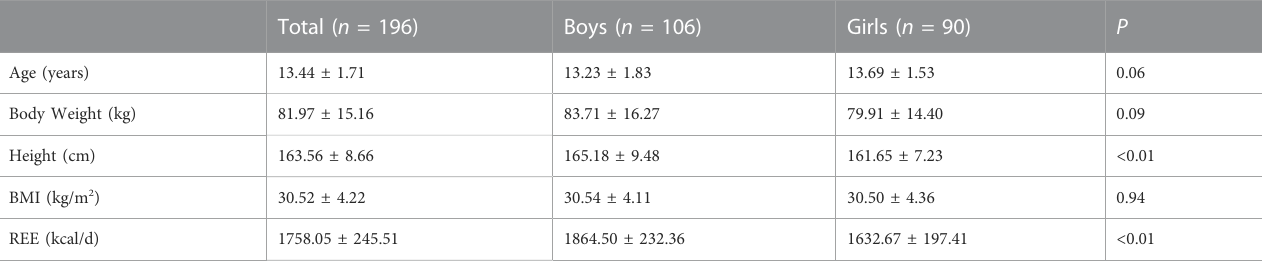
TABLE 1 Baseline characteristics of